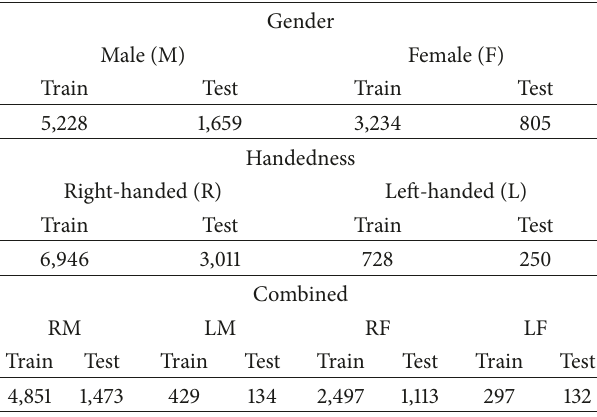
Table 1: Number of training and text lines, per subclass and experiment, from Offline IAM database.